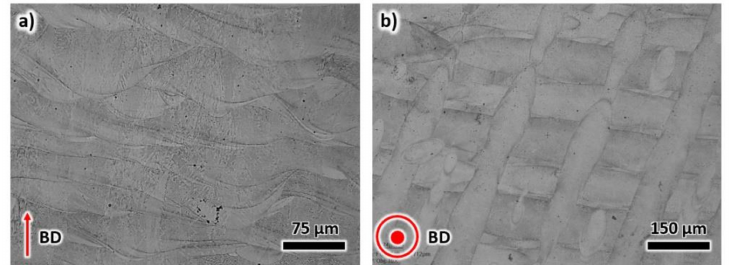
Figure 2. The optical microstructure of the as-printed sample along the ( a ) building direction, and ( b ) transverse direction.